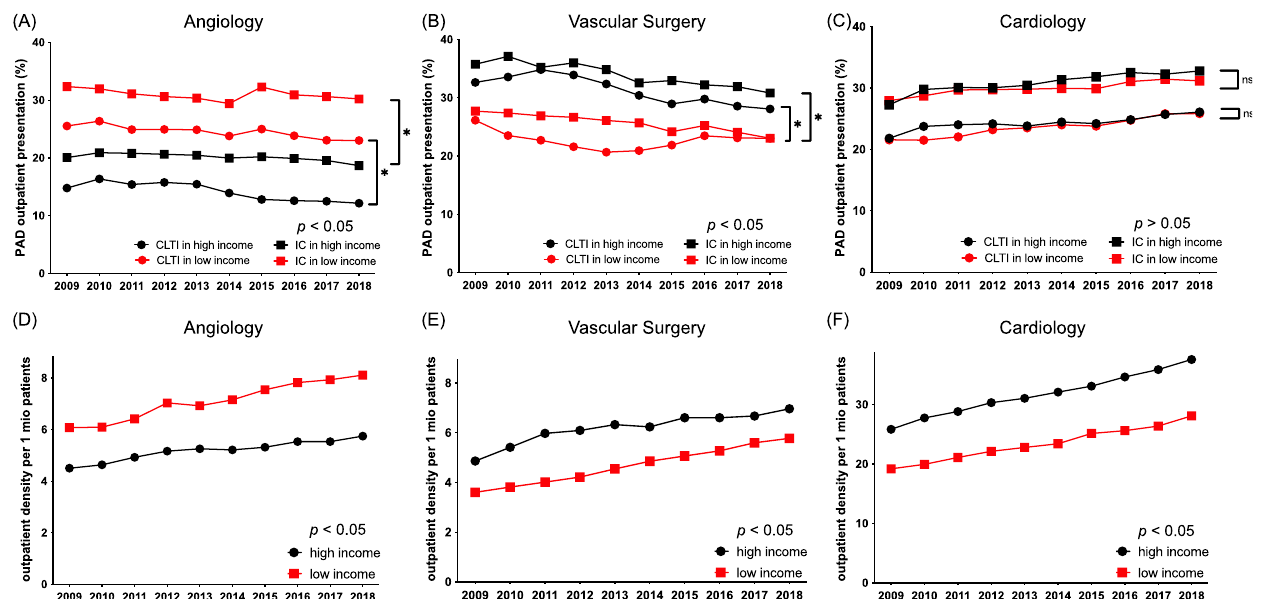
Figure 4. Patient presentation rates ( A – C ) and outpatient density ( D – F ) of specialized vascular care stratified by income level and specialty (angiology ( A , D ), vascular surgery ( B , E ), cardiology ( C , F )) (* denotes p < 0.05, ns denotes not significant).